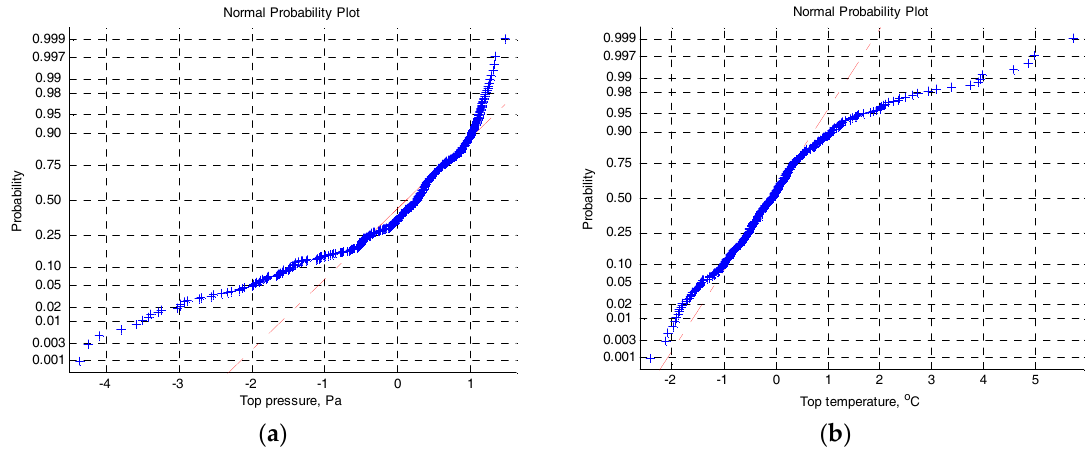
Figure 2. ( a ) The normal probability plot of the top pressure variable in the training set; and ( b ) the normal probability plot of the top temperature variable in the training set.